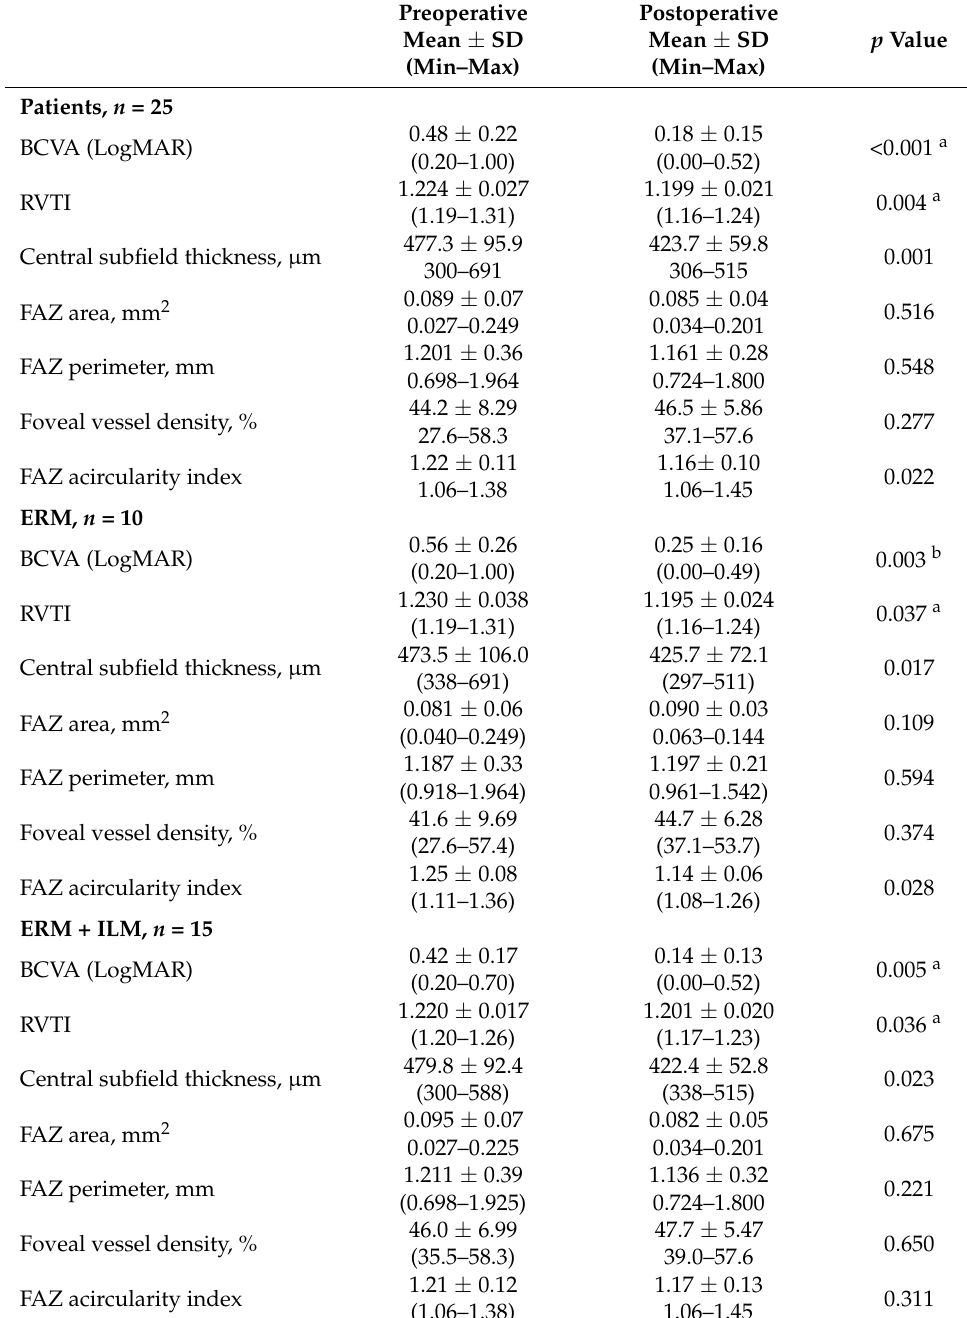
Table 1. Comparison of the mean best corrected visual acuities, retinal vascular tortuosity indices, central subfield thicknesses, and FAZ parameters in patients undergoing surgery for idiopathic epiretinal membrane before and after 25G pars plana